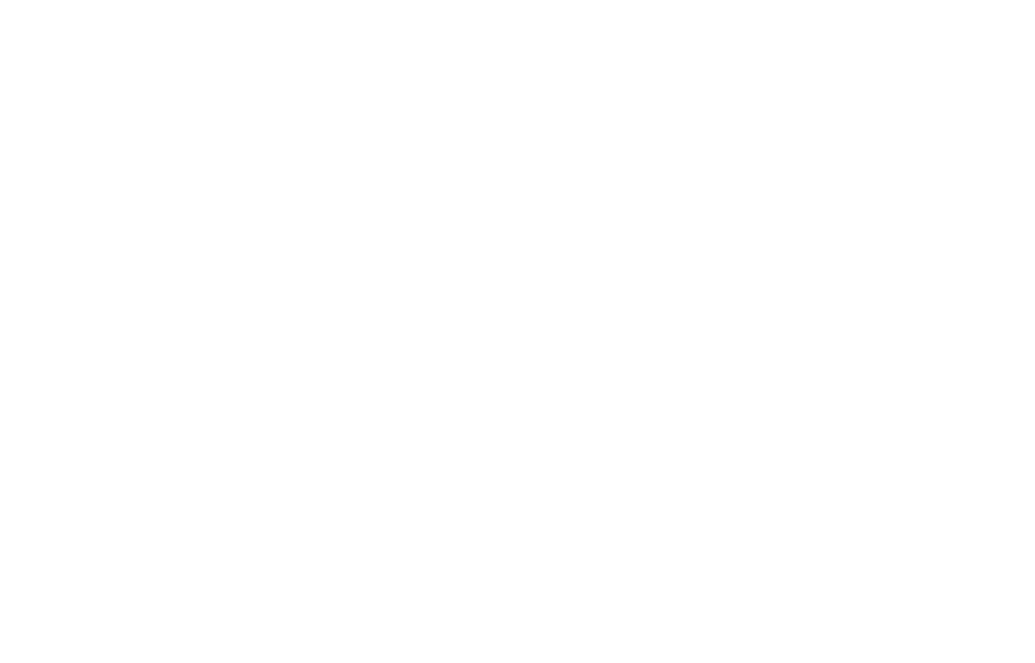
almost12fromoneedition ofThomson Reuters’“Journal CitationReports” to the next is due to a retrospective adjustment of the number of items published (marked), while the actual citations remained relatively